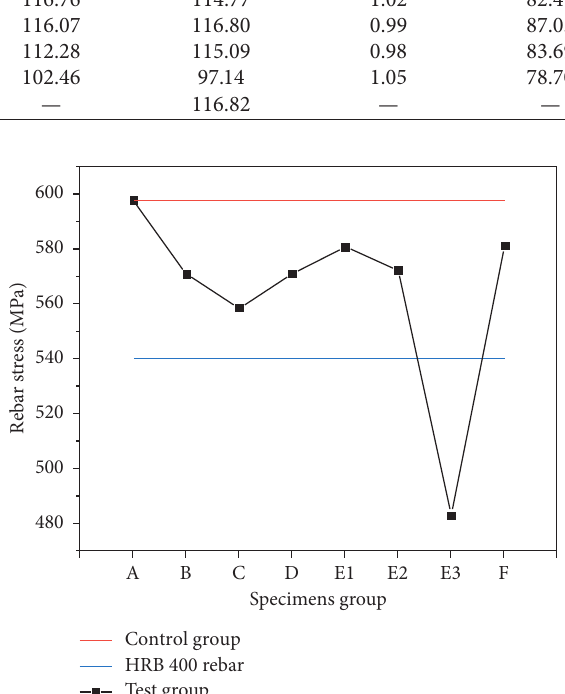
Figure 19: Comparison of rebar stress (unit: MPa). A, control group; B, insufficient grout height specimen; C, insufficient compactness specimen; D, rebar offset specimen; E, insufficient rebar anchor length specimen (E1: 7.5 d, E2: 6.5d, and E3: 5.5d); F, overtime grouting